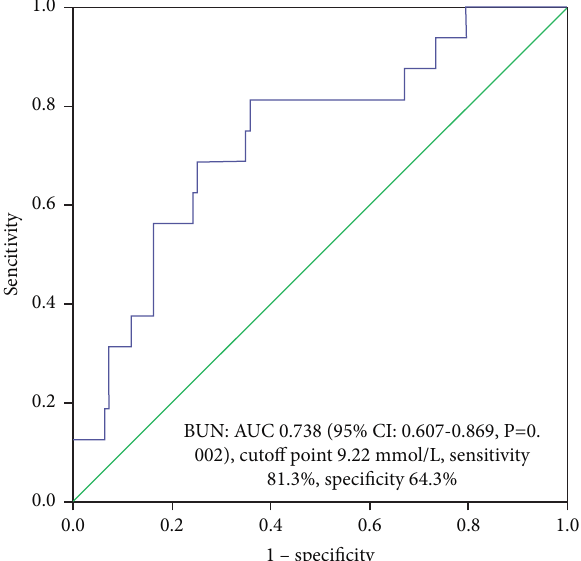
Figure 3: The AUC of BUN before treatment was calculated to be 0.738 (95% Cl: 0.607–0.869, p � 0 . 002) with a cutoff point of 9.22mmol/L yielding a sensitivity and specificity of 81.3% and 64.3%, respectively. Total bilirubin: AUC: 0.69,(95% CI: 0.557-0.824,P=0.014), cutoff point 8.55 umol/L, sensitivity 93.8%,specificity 40.9%